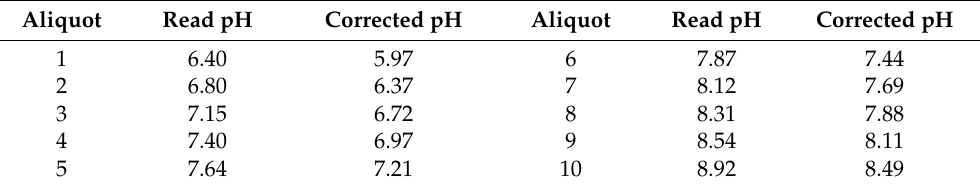
Table 4. The pH values obtained for each of the aliquots, using the methyl red, and their corrected values.